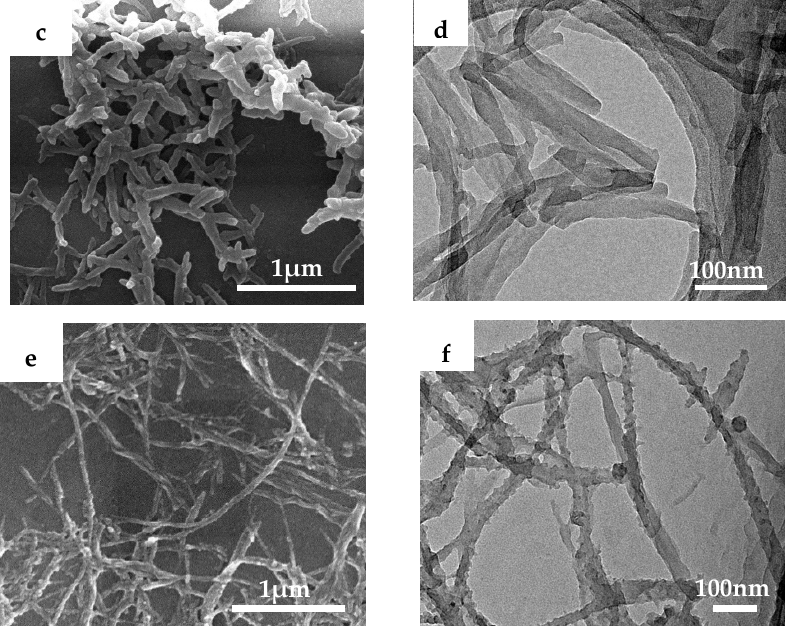
Figure 2. The spectra and morphology of PANi and CNTs@PANi: ( a ) FTIR; ( b ) UV–vis; ( c ) SEM image of PANi; ( d ) TEM image of PANi; ( e ) SEM image of CNTs@PANi; ( f ) TEM image of CNTs@PANi.